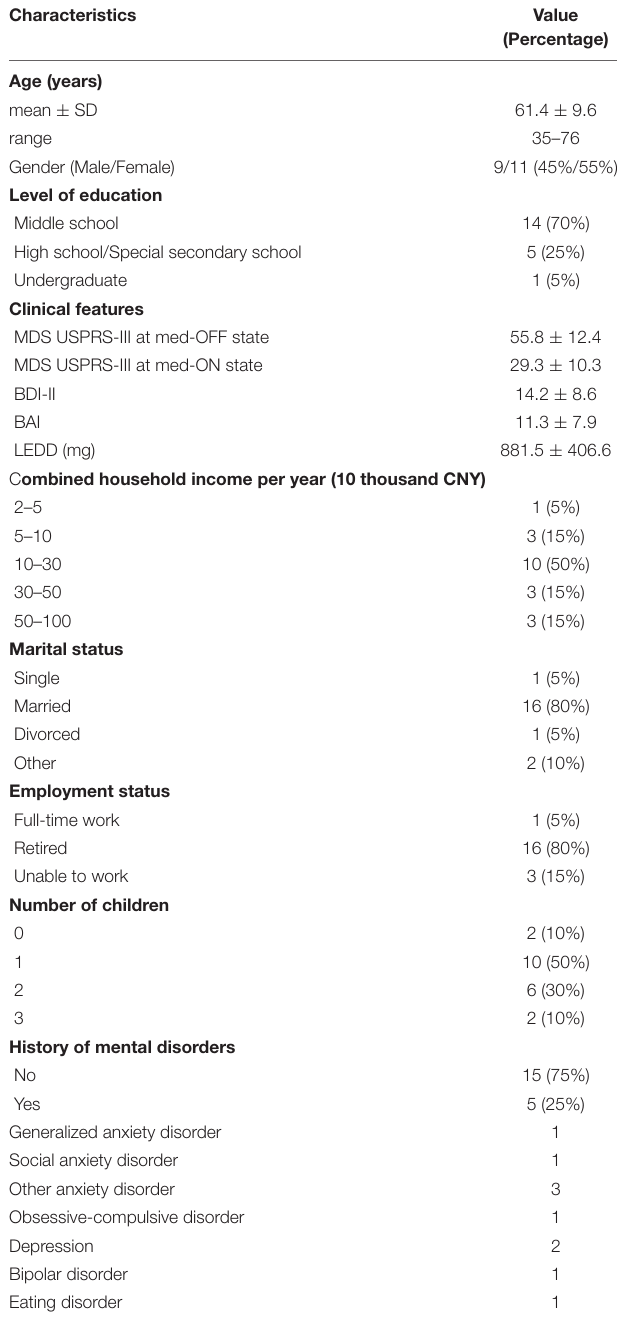
TABLE 1 | Patients’ demographics and clinical information ( N =